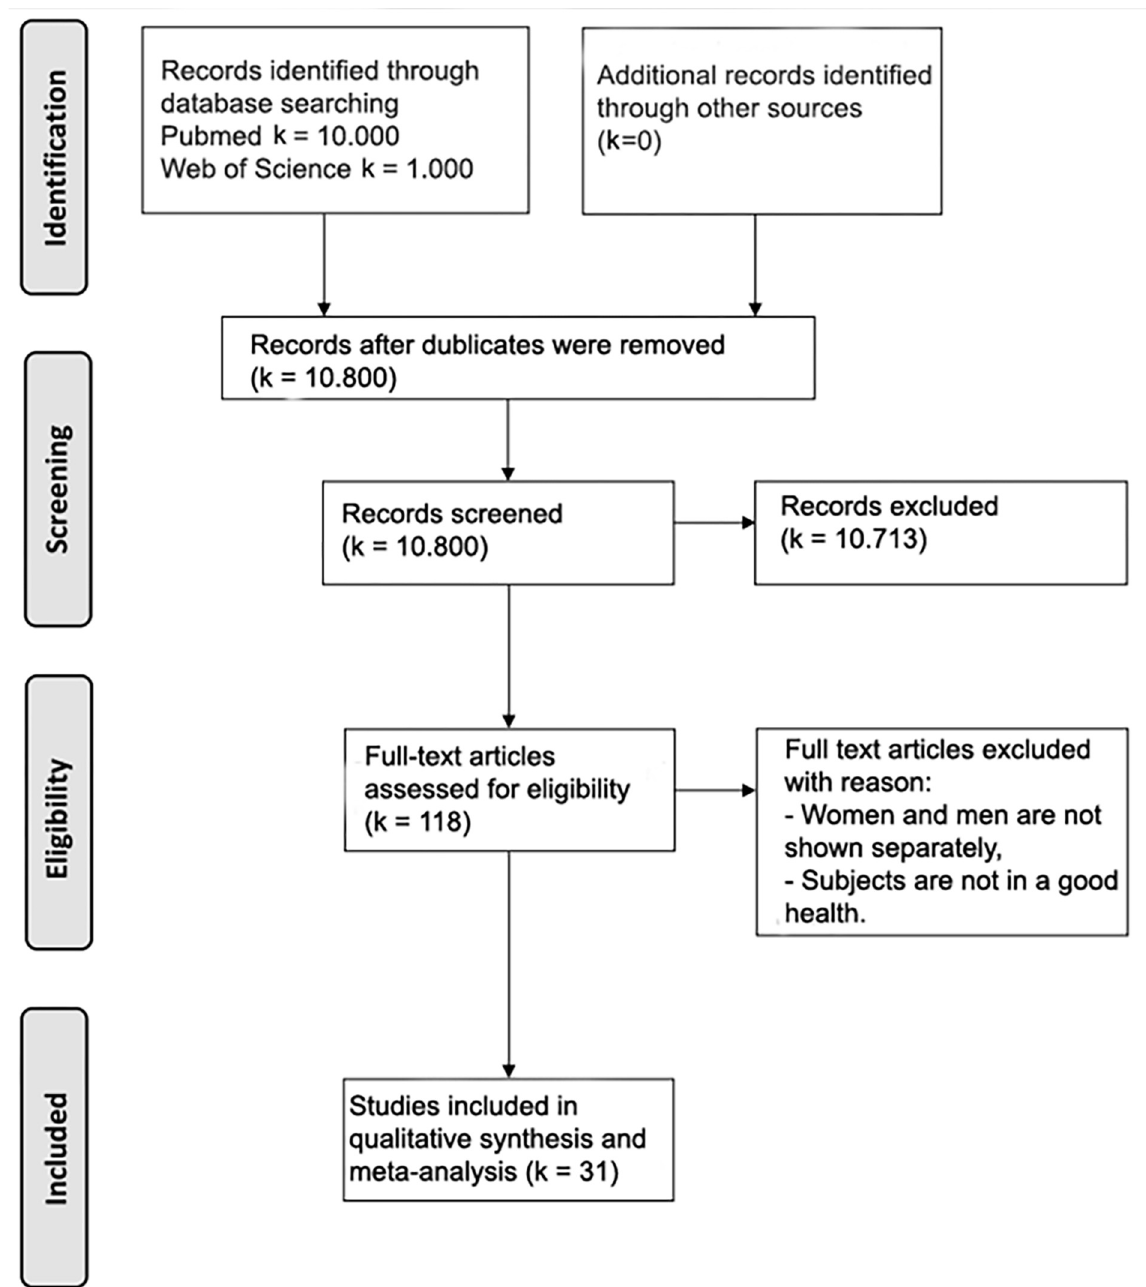
Fig 1. PRISMA flowchart. Review and selection process of all data records from the two databases: PubMed and Web of Science from the first data export to the final qualitative analysis. https://doi.org/10.1371/journal.pone.0284216.g001 study features randomisation of the intervention or control groups. #3 stands for a hidden allo- cation to the groups. #4 represents whether or not all uniform parameters were similar in all groups at the beginning. #5 stands for the blinding of participating subjects. #6 notes whether or not trainers or therapists were blinded. #7 indicates the blinding of an investigator who measured an outcome. #8 means that at least 85% of the subjects completed the study